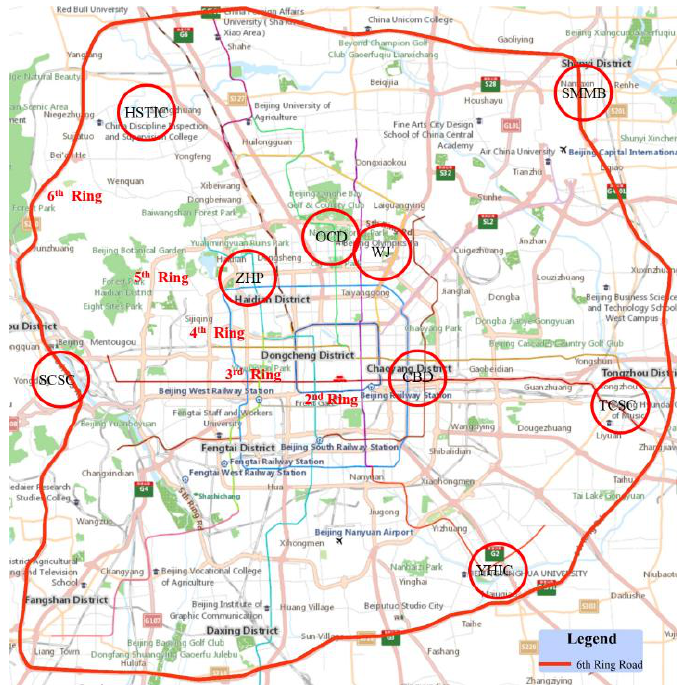
Figure 6. Research area and core function regions of Beijing.